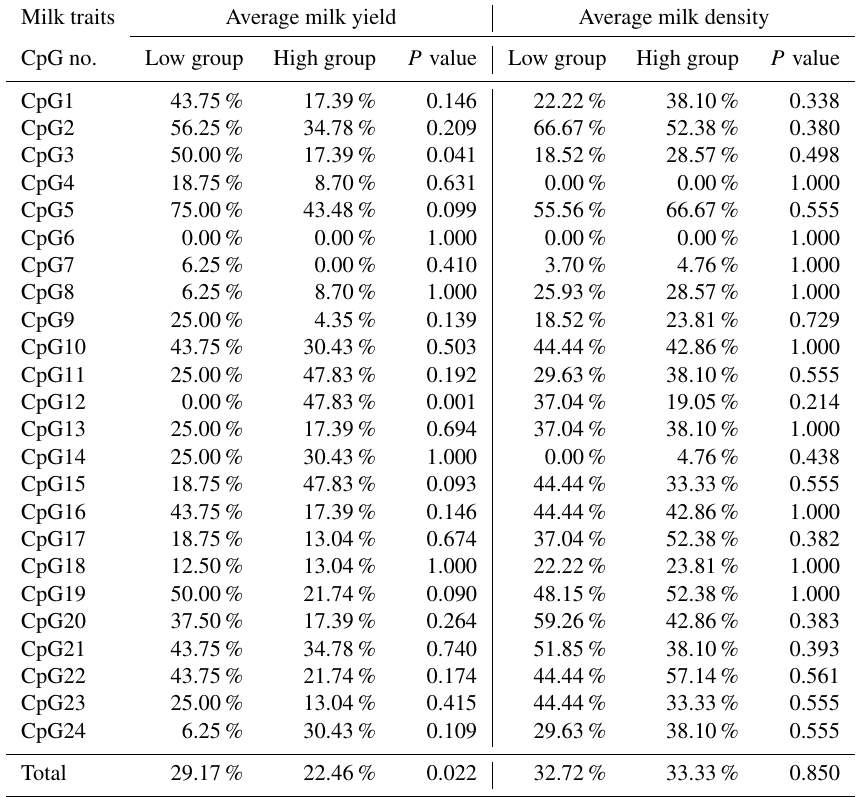
Table 3. Methylation percentage and P value difference of each CpG-dinucleotide locus between the low and high groups.